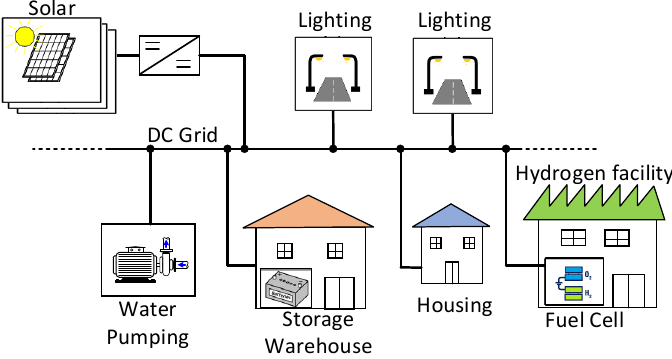
Figure 15. A vision for an isolated DC infrastructure in a rural context.